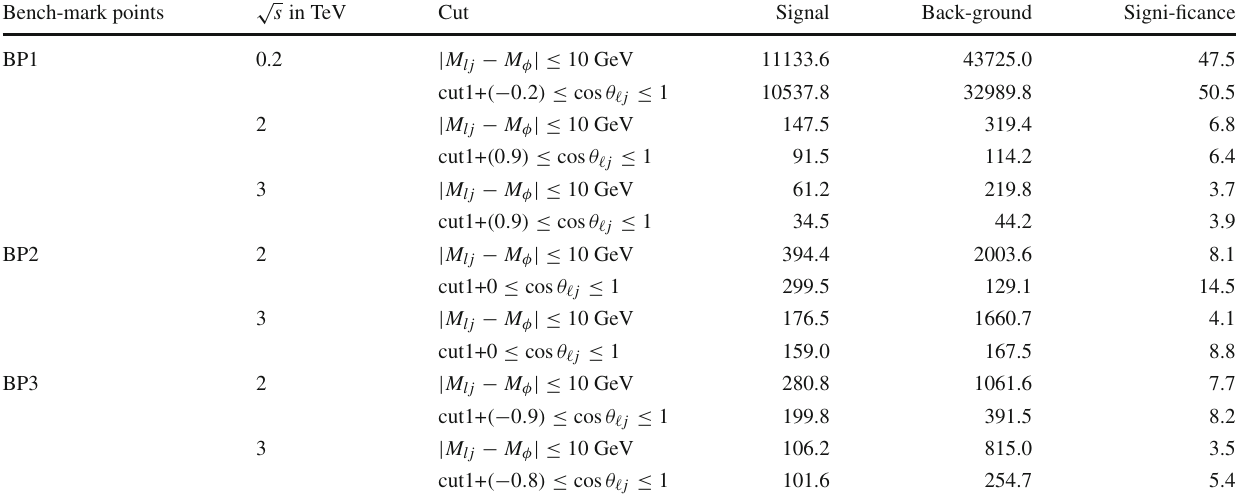
Table 6 Signal-background analysis for leptoquark ( S + 1 / 3 ) c with luminosity 100 fb − 1 at e – γ collider √ s in TeV Cut Signal Back-ground Bench-mark points